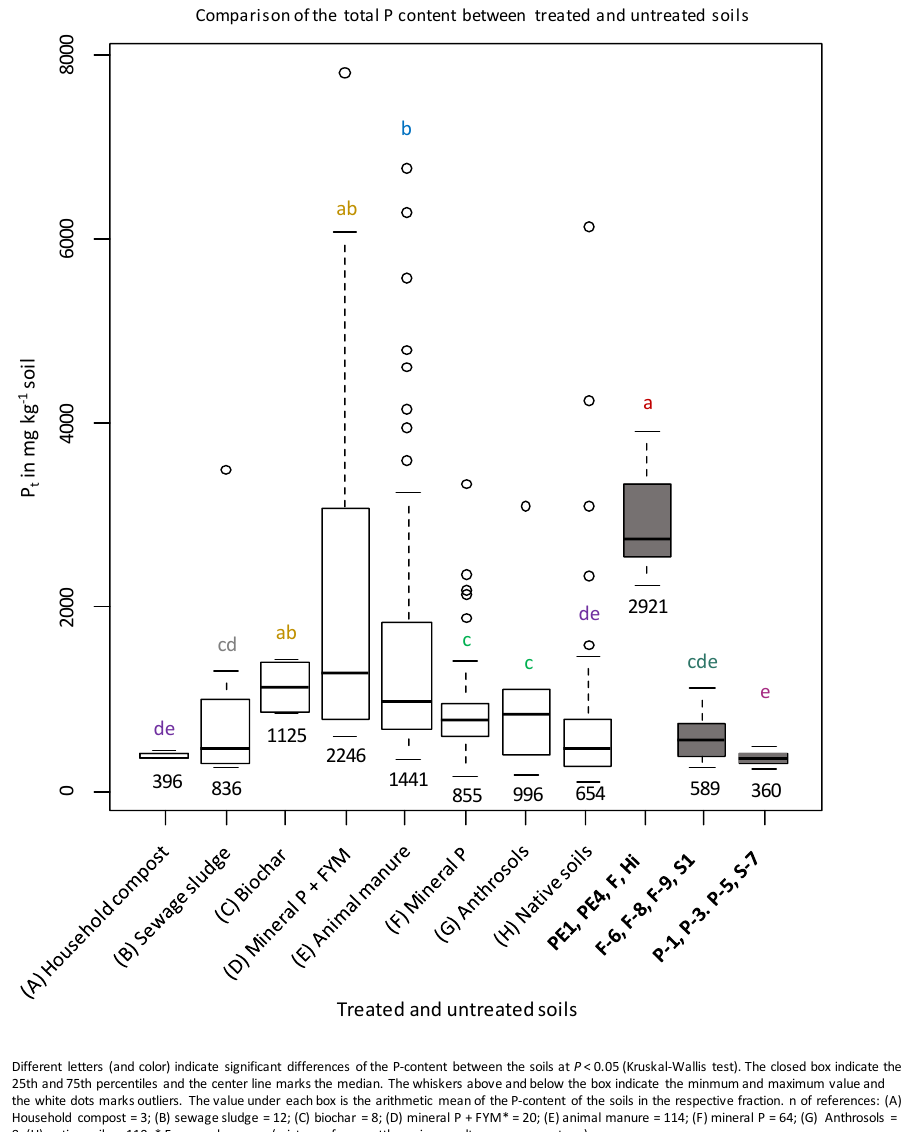
Figure 6. Box plot of the P t concentrations in the Anthrosols of this study, in reference soils with different amendments, Anthrosols, and in native soils. References: A: [51]; B: [51,52,90,91]; C: [92]; D: [93 – 98]; E: [51,53,58,83,93 – 107]; F: [51,58,62,93,94,96 – 98,100,104,106 – 112]; G: [109,110]; H: [52,83,91,93,100,103 – 105,110,113 – 123], Negassa W. (unpublished data).